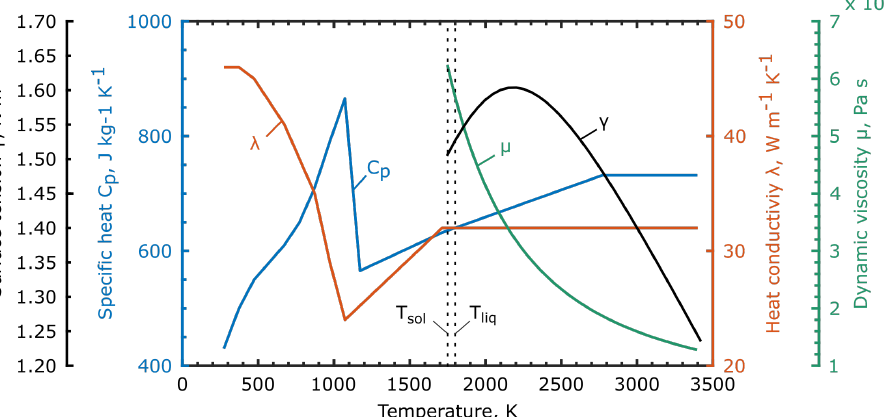
Figure 5. Thermo-physical material properties for unalloyed steel used in the multi-physics model